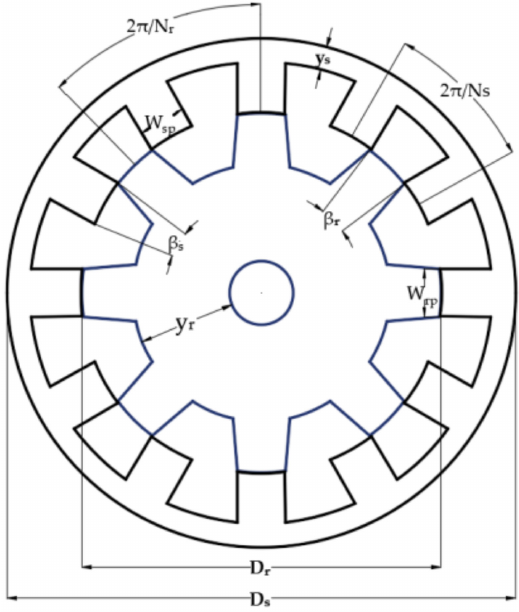
Figure 1. Cross sectional view of 12/8